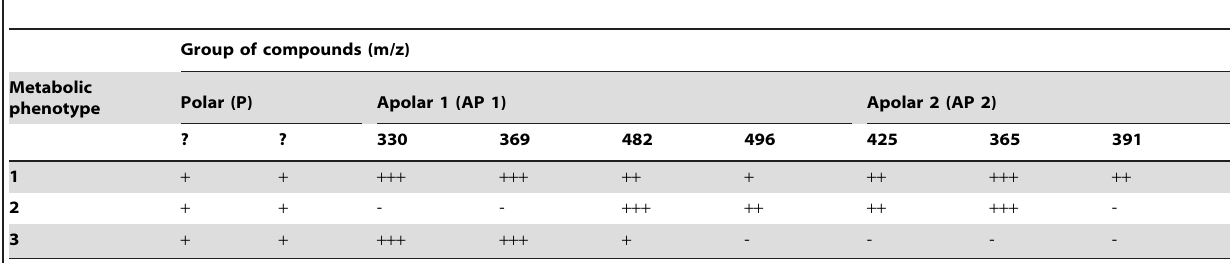
The expression level of each annotated compound is indicated by the following symbols: ‘‘-’’ in trace, ‘‘ + ’’ low, ‘‘ ++ ’’ medium and ‘‘ +++ ’’ high.